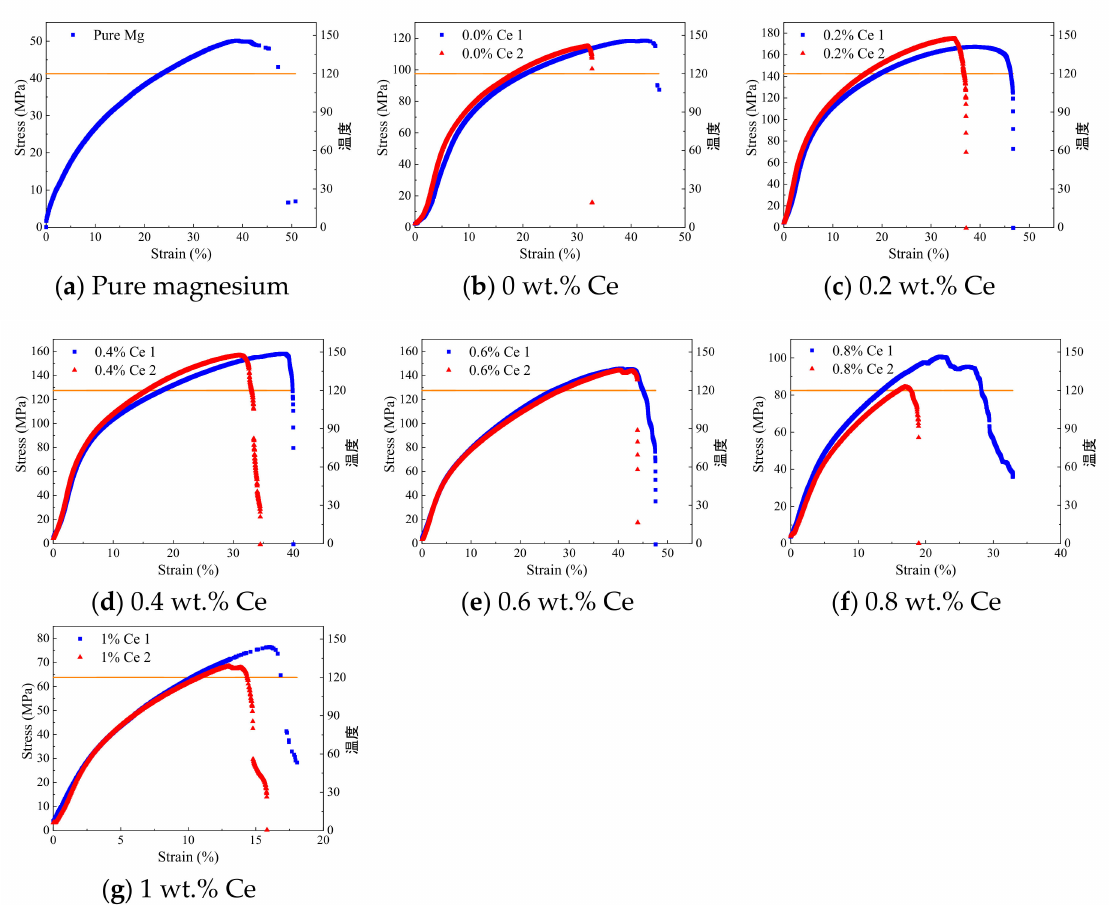
Figure 9. The tensile curves of the samples with different Ce content at high temperature. The Chinese on the right sides means